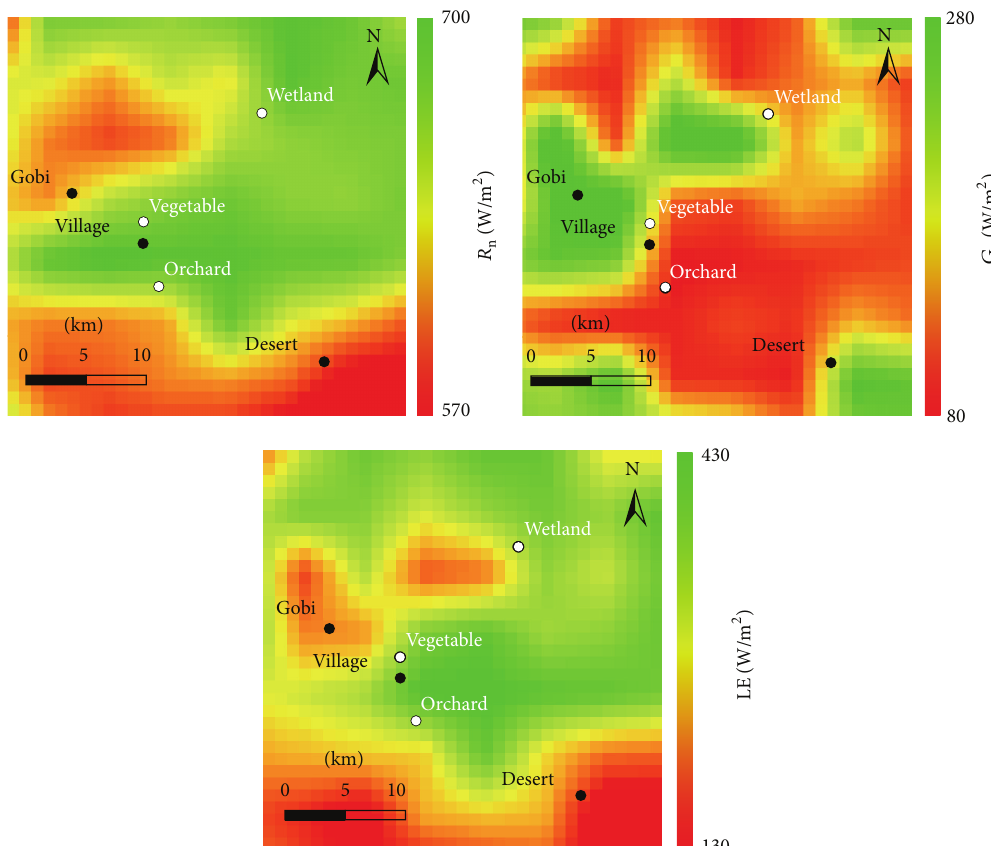
Figure 3: Distributions of the retrieved net radiation ( 𝑅 (UTC) in August 20, 2012.